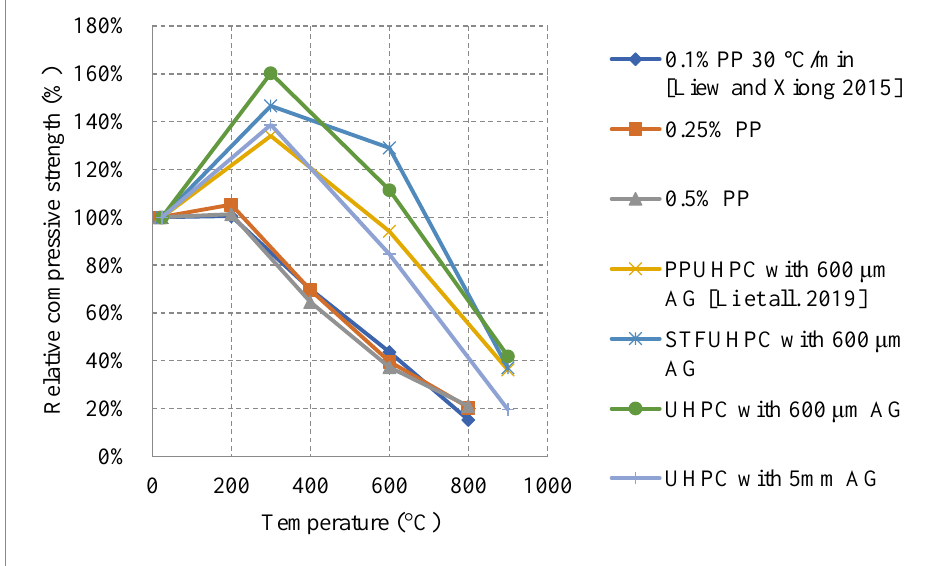
Figure 28. Relative compressive strength of furnace cooled UHPC with different constituents 2 [47,95].